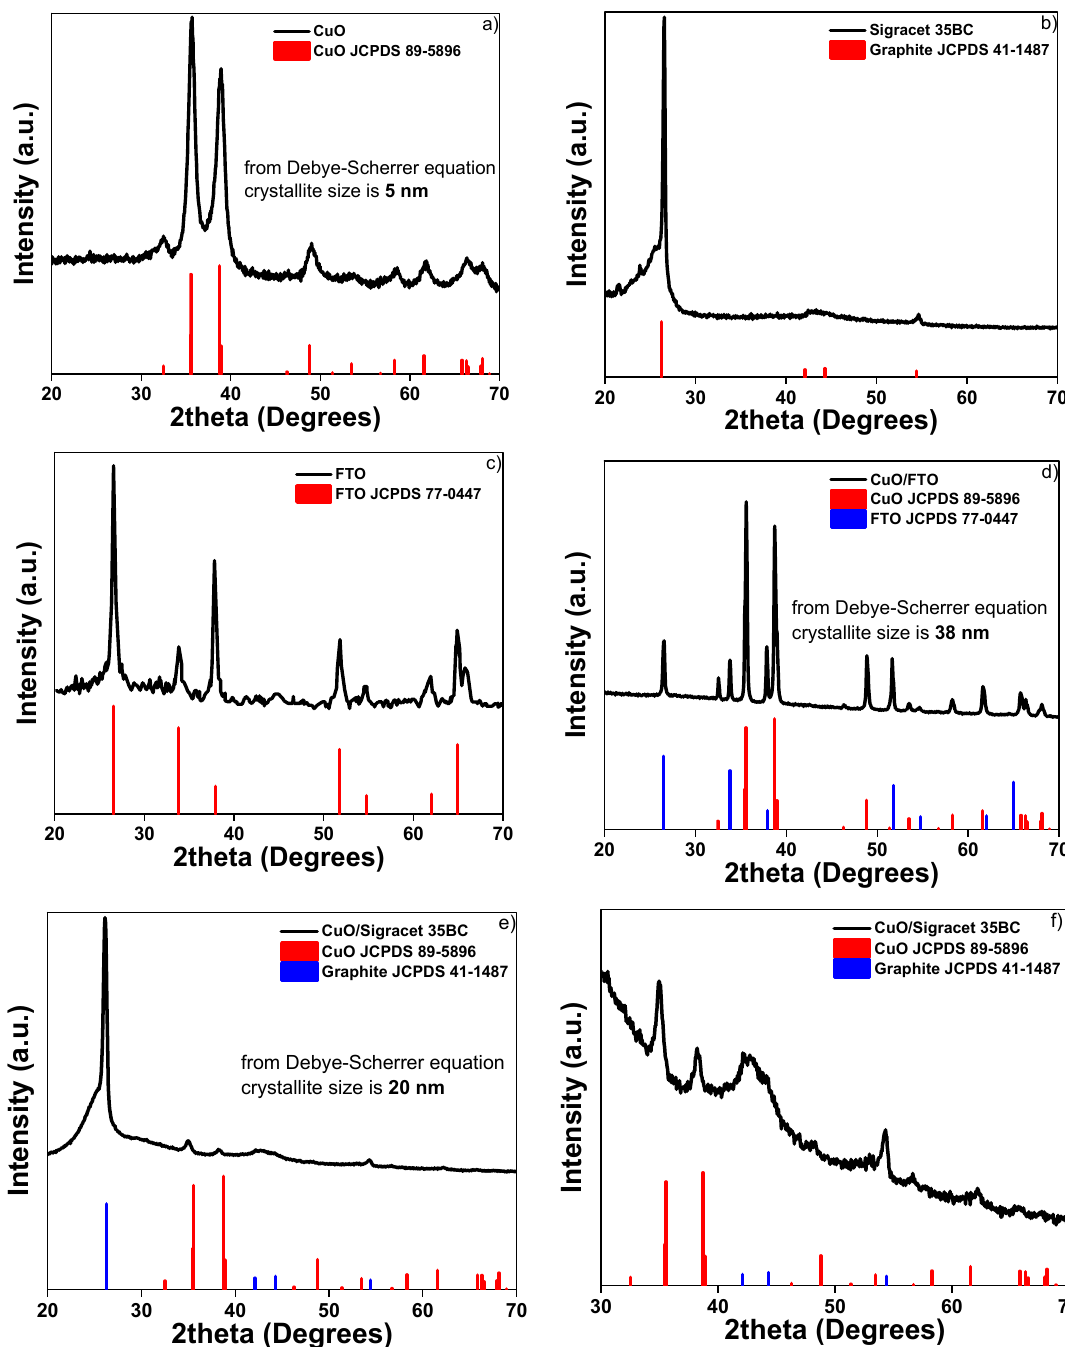
Figure 4. XRD patterns for synthesised photocathode CuO ( a ), Sigracet 35BC ® gas diffusion layer ( b ) FTO on glass ( c ), CuO deposited on FTO glass ( d ), CuO deposited on Sigracet 35BC ® gas diffusion layer ( e , f ) and relative JCPDS cards.